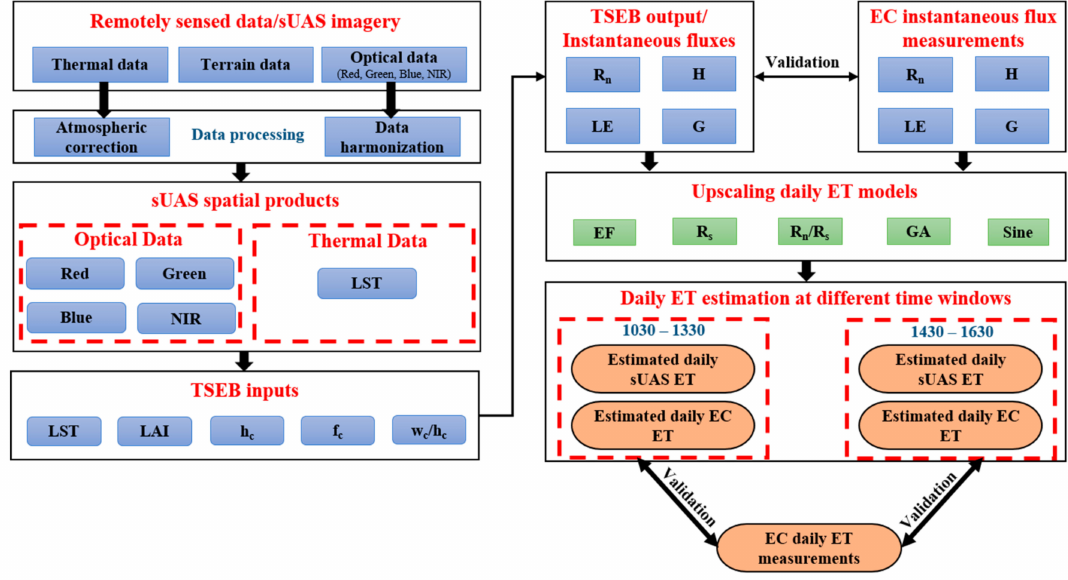
Figure 3. Study methodology for assessing different upscaling daily ET methods in sUAS